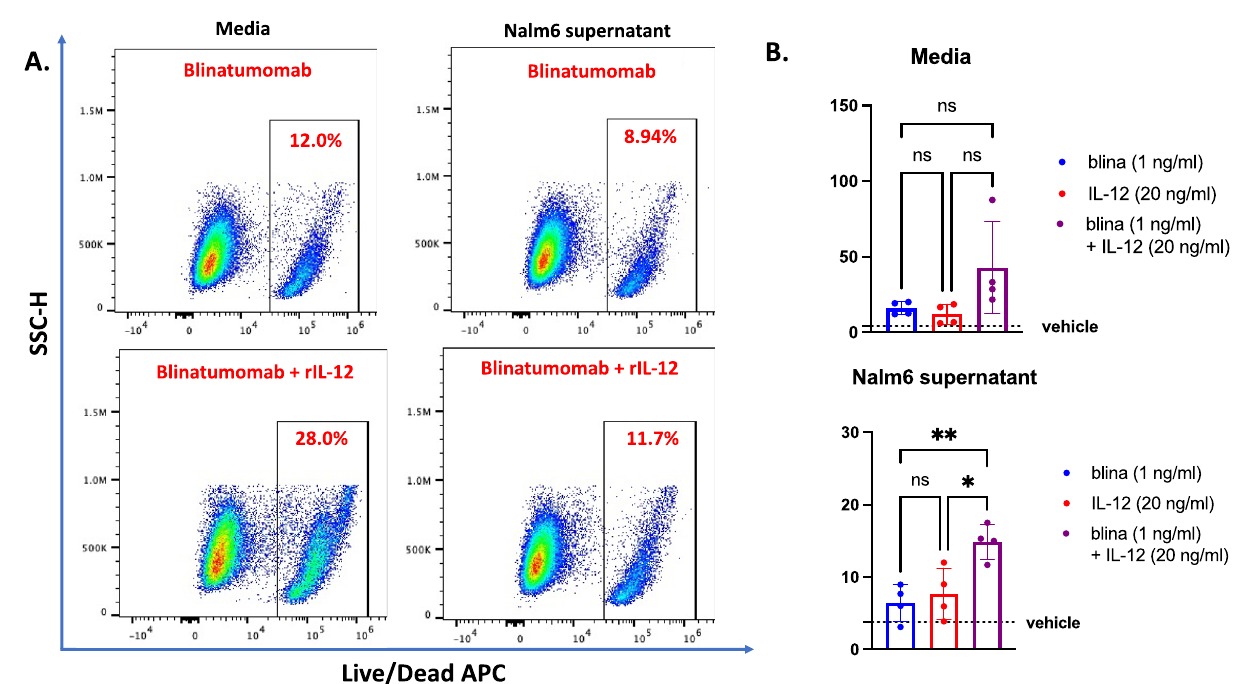
Figure 7. IL-12 overcomes reduced blinatumomab efficacy in the B-ALL secretome. ( A ) Representative flow cytometry plots of T-cell cytolytic activity showing leukemia cell death in different experimental conditions. ( B ) Leukemia cell death from T-cell cytolytic killing cultured in either control media (top panel) or Nalm6 supernatant (bottom panel) ( n = 4 donors; * P < 0.05; ** P < 0.01; **** P < 0.0001, ANOVA with Tukey multiple comparisons